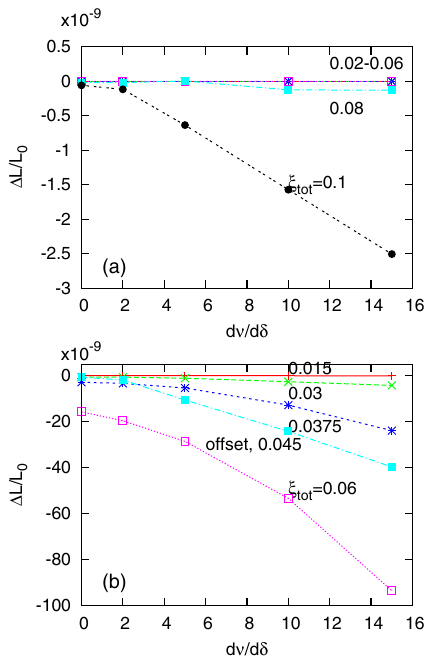
FIG. 15. Luminosity decrement as a function of chromaticity without (a) and with crossing angle (b). The cyan line in (b) refers to a transverse offset of 0 . 2 σ and total tune shift ξ